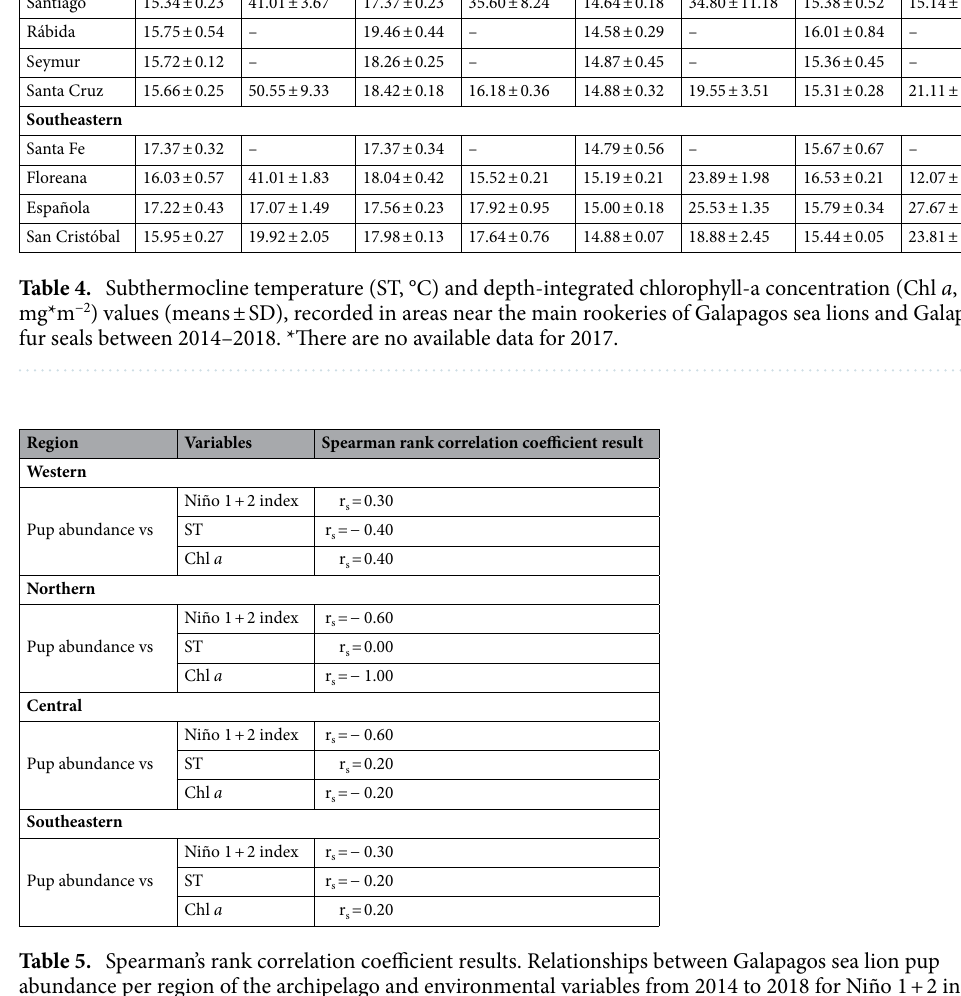
Table 4. There were no significant relationships between the oceanographic variables and the GSL and GFS pup abundances in any region of the archipelago (Tables 5, 6). Pup abundance of GSL showed a slight negative trend with the El Niño 1 + 2 index and ST values in most regions, and a positive trend with the depth-integrated chl a data in the western and southeastern regions (Table 5). While the pup abundance of GFS showed a negative trend with the El Niño 1 + 2 index and ST values, and a positive trend with the depth-integrated chl a data in all regions (Table 6). In the GSL, the tendency with the El Niño 1 + 2 index is stronger in the north and central regions, less evi- dent in the southeastern region and was not observed in the west (Fig. 4A). The relationships between GSL pup abundance and ST and chl a were as expected (negative with ST and positive with chl a ) in the west and south- eastern regions, but contrary in the north and central regions. In the GFS, the negative relationships between